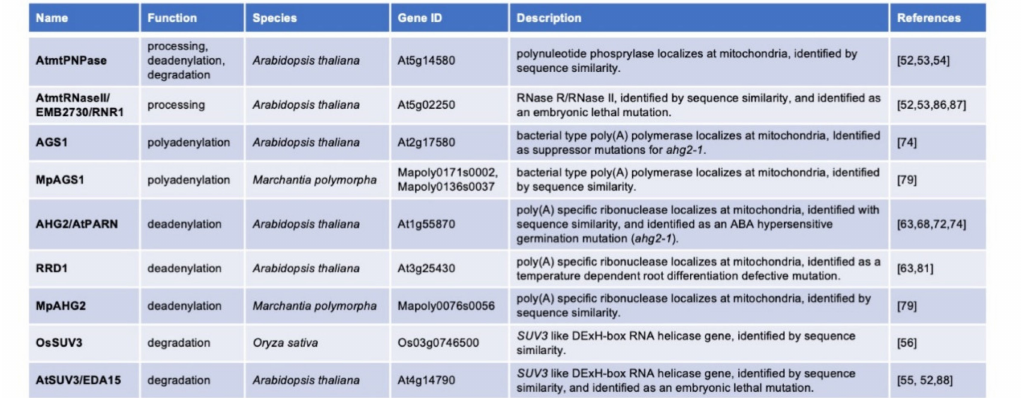
Figure 1. Processing of plant mitochondrial mRNAs. Upper panel: In land plant mitochondria, genes in the mitochondrial genome are transcribed separately by T3/T7 phage type RNA polymerases (RpoTm and RpoTmp) [26–28]. Primary transcripts of protein coding mRNAs are trimmed at their 5 (cid:48) and 3 (cid:48) ends by polynucleotide phosphorylase (PNPase) and RNase II [26,27,29,30]. Some mRNA is edited at specific residues by pentatricopeptide repeat proteins (PPRs). Unknown regulatory signals then induce polyadenylation at the 3 (cid:48) ends of the mRNAs via a poly(A) polymerase (PAP) such as AHG2 SUPPRESSOR1 (AGS1) [31]. RNAs with abnormal structures are degraded by the mRNA quality surveillance machinery. Polyadenylated mRNA is believed to be degraded by RNase following its deadenylation by poly(A)-specific ribonucleases (PARNs) such as ABA-HYPERSENSITIVE GERMINATION2 (AHG2)/AtPARN [31–34] and ROOT REDIFFERENTIATION DEFECTIVE1 (RRD1) [32,35]. PNPase may participate in this process. MpAGS1 and MpAHG2 are Marchantia paralogs of Arabidopsis AGS1 and AHG2 [36], respectively. SUV3-like proteins may be involved in certain processes (right side) [26,37–39]. tRNAs (and rRNAs) with abnormal structures and byproducts of mRNA processing are also polyadenylated and degraded, presumably by PNPase and the SUV3-like protein complex, as observed in human mitochondria (left side). Lower panel: the information of the factors shown in the upper panel. ? mark means that the involvement of these factors have been suggested but not confirmed